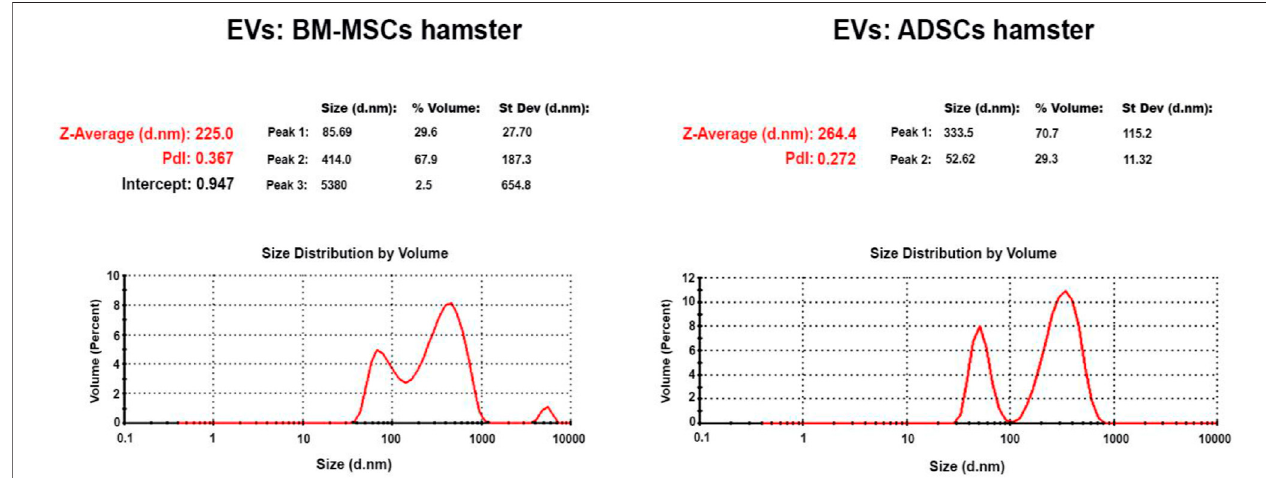
FIGURE 2 | Particle size distribution of EVs secreted in the culture medium by ADSCs and BM-MSCs showed two different populations represented by the two peaks; the fi rst peak at thesmall sizerange (~50 – 100 nm)speci fi ctoexosomesand thesecond at thehigh-sizerange (~100 – 1000 nm) speci fi ctomicrovesicles( Y -axis represents the number of EVs, and the X -axis represents the size of